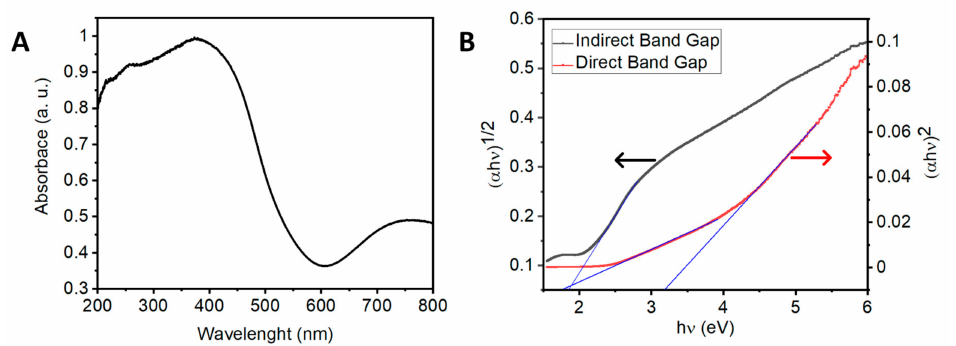
Figure 5. Optical characterization of Cu-VO ( A ) UV–Vis/near-infrared (NIR) absorption spectrum of the Cu-VO and ( B ) Tauc’s plot for indirect and direct band gap transition derived from the UV–Vis absorption.